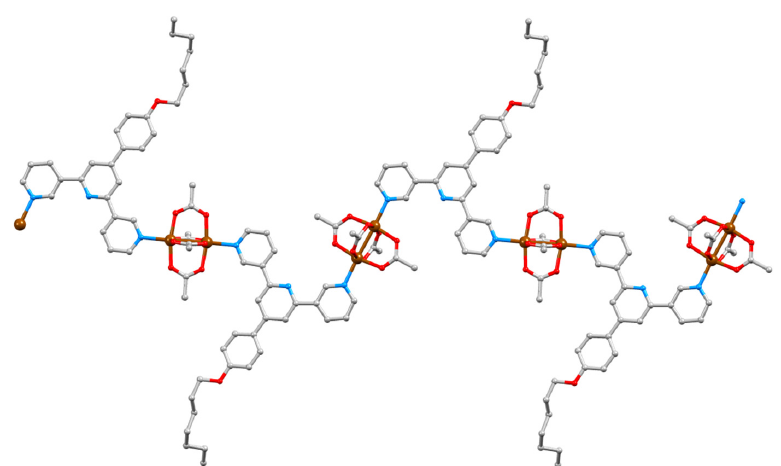
Figure13. Partofonechainin[{Cu 2 ( µ -OAc) 4 ( 4 )} · 0.2CHCl 3 ] n withacoordinationsequenceofalternating Figure 13. Part of one chain in [{Cu 2 ( μ -OAc) 4 ( 4 )} . 0.2CHCl 3 ] n with a coordination sequence of out / out and in / in at each paddle-wheel unit. The n -heptyl chain is disordered. and only the major alternating out/out and in/in at each paddle-wheel unit. The n -heptyl chain is disordered. and only occupancy site is shown; H atoms and solvent molecules omitted for clarity. the major occupancy site is shown; H atoms and solvent molecules omitted for clarity.